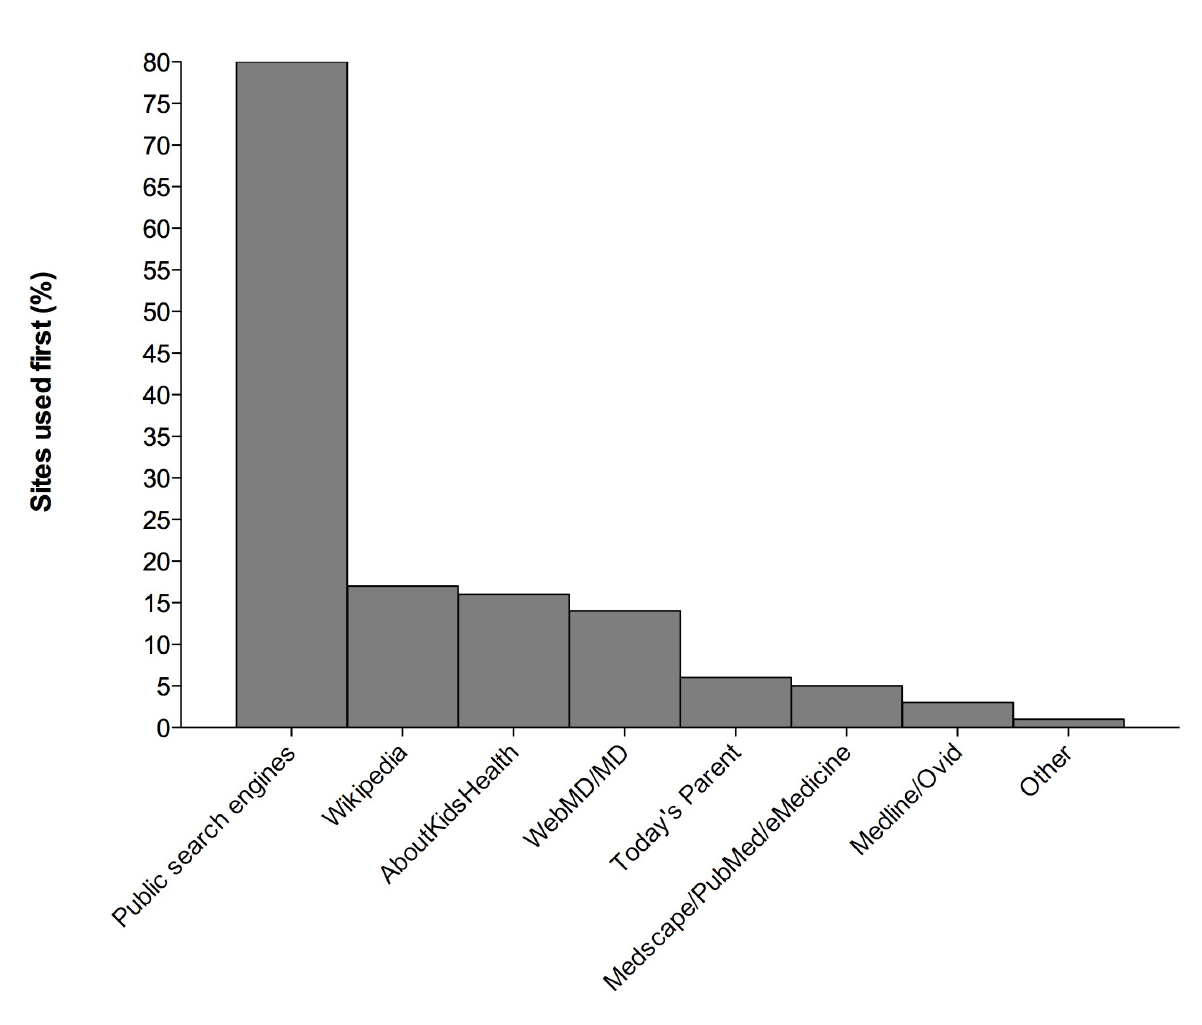
Figure 3. Sites first accessed for health-related